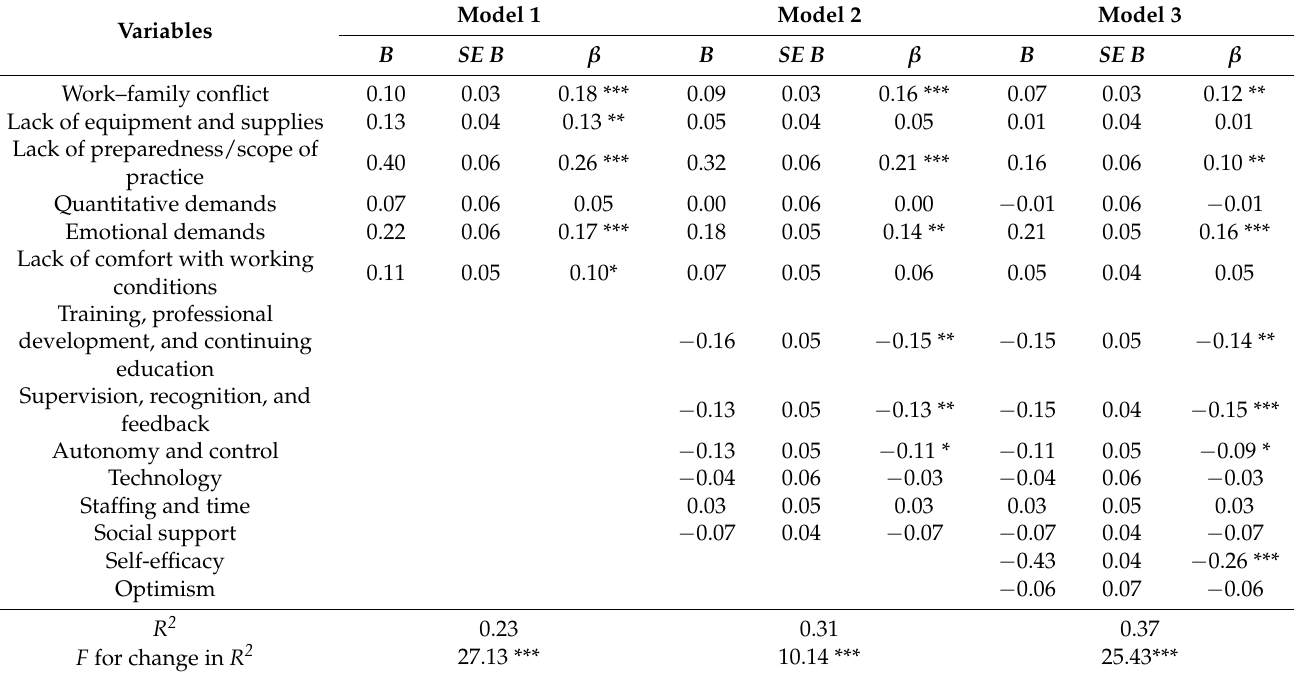
Table 3. Summary of hierarchical regression analysis for variables predicting burnout ( n =